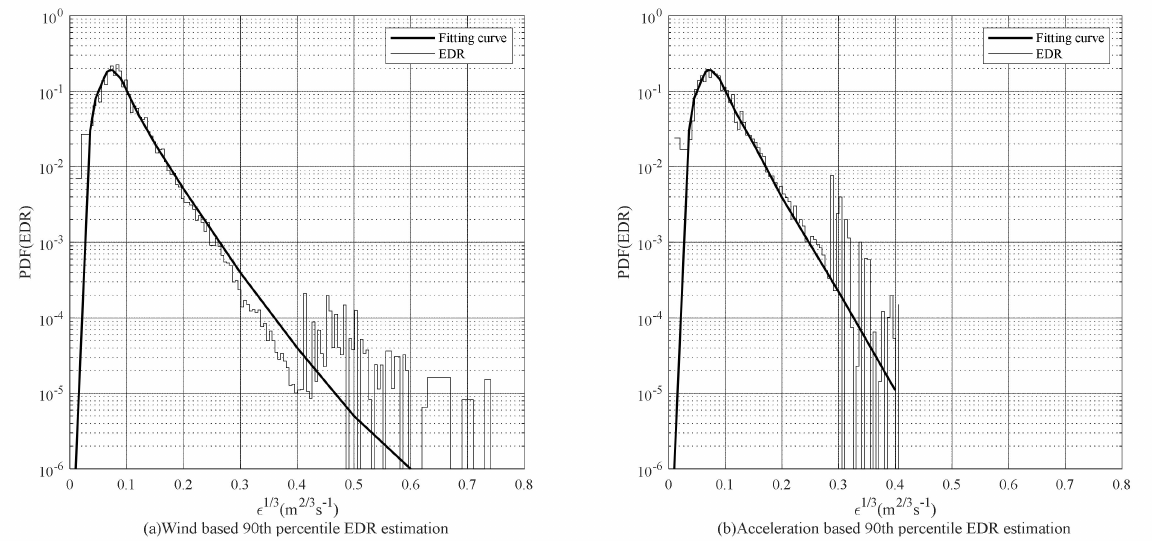
Figure 12. The comparison of acceleration-based and wind-based EDR estimation: ( a ) the PDF of the wind based 90th percentile EDR estimation. ( b ) the PDF of the acceleration based 90th percentile EDR